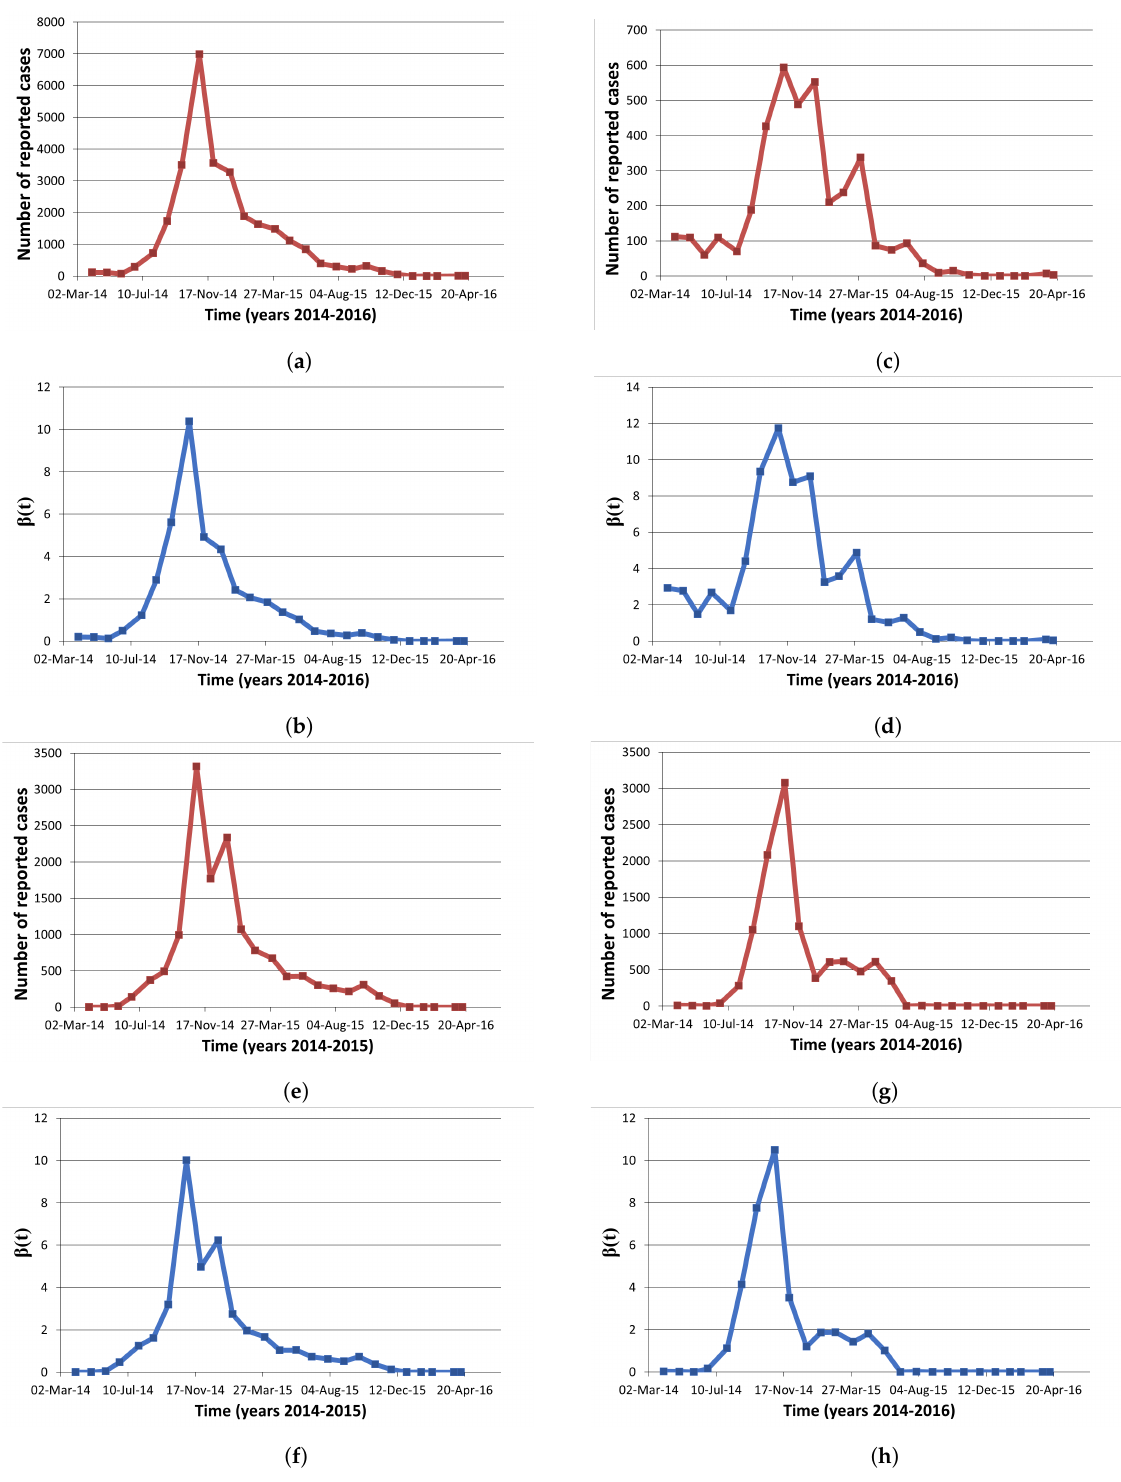
Figure 3. β ( t ) estimates for the 2014–2016 Ebola outbreak: ( a ) Cases per month for West Africa; ( b ) β ( t ) estimates for West Africa; ( c ) Cases per month for Guinea; ( d ) β ( t ) estimates for Guinea; ( e ) Cases per month for Sierra Leone; ( f ) β ( t ) estimates for Sierra Leone; ( g ) Cases per month for Liberia; ( h ) β ( t ) estimates for